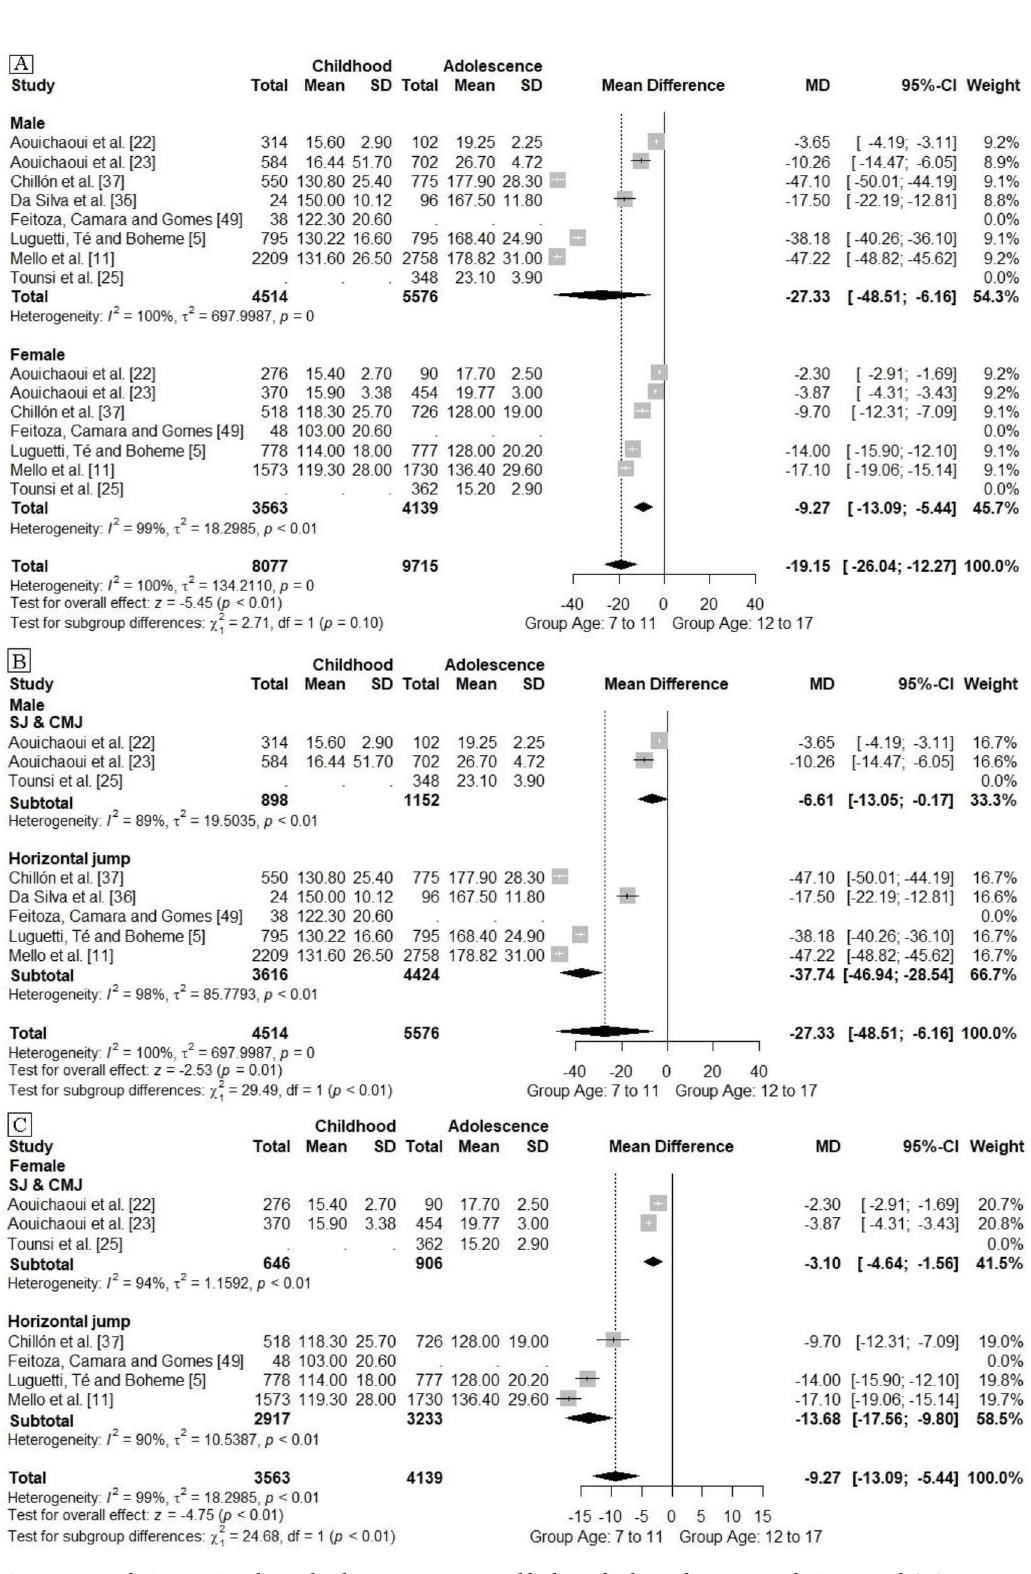
PLOS ONE | https://doi.org/10.1371/journal.pone.0258144 October 6, 2021 12 /